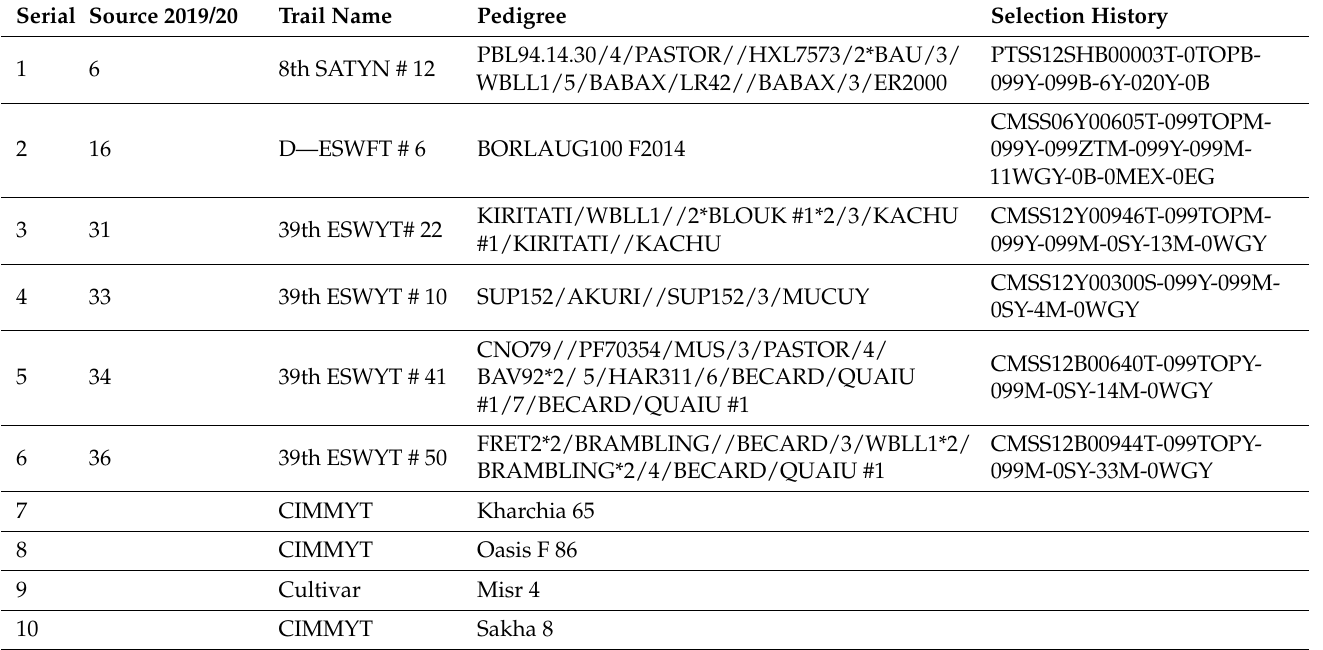
Table 2. The selected ten elite entries out of forty genotypes for evaluation in a simulated lysimeter under diluted seawater or control (tap water) in seasons